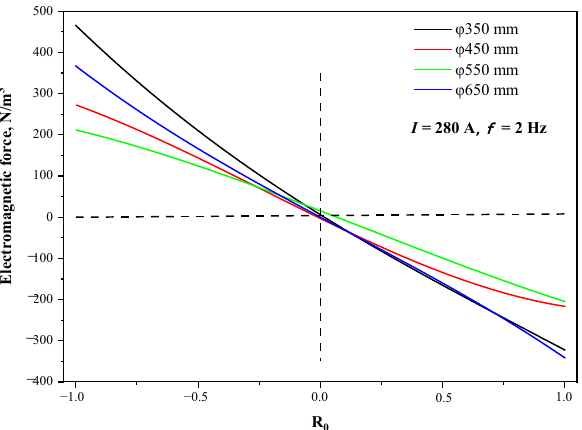
Figure 13. Distribution of electromagnetic force on the radial line of the strand in the center of the stirrer at different sections. stirrer at different